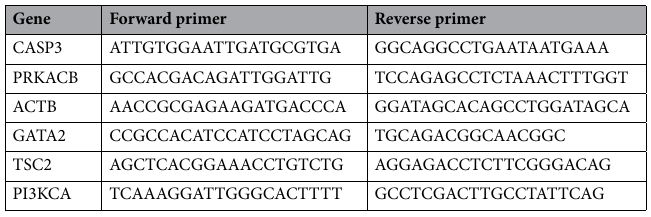
Table 1. Primers for real time